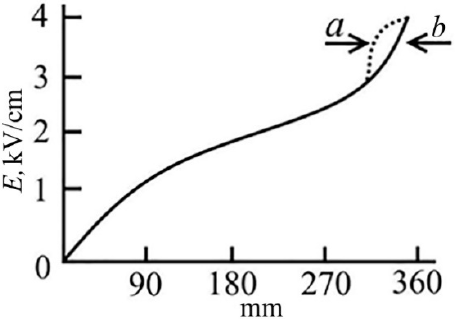
Figure 10. Distribution of the field strength between the ends of the defective (a) and defect-free (b) insulators. The change in the field on the defect is shown by a dotted line.